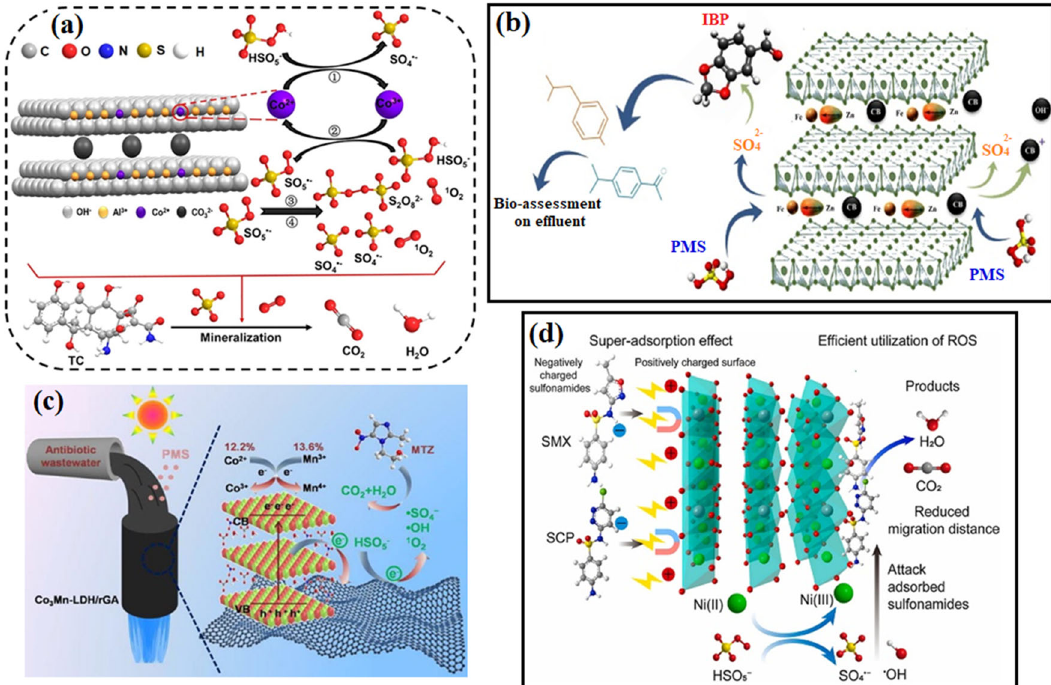
Fig. 4 The plausible degradation mechanisms of pharmaceutical residues by the LDHs/PMS system. a The TC degradation by AlCo-LDH/ PMS system, adapted with permission from ref. 135 , Copyright, 2022, Elsevier, b the IBP degradation by Carbon-ZnFe LDH/PMS system, adapted with permission from ref. 136 Copyright, 2021, Elsevier, c the MTZ degradation using 3D Co 3 Mn-LDH/rGA/PMS system, adapted with permission from ref. 137 Copyright, 2021, Elsevier and d the possible mechanism of SMX and SCP degradation by ultrathin-NiAl-LDH/PMS system, adapted with permission from ref. 138 Copyright, 2022,